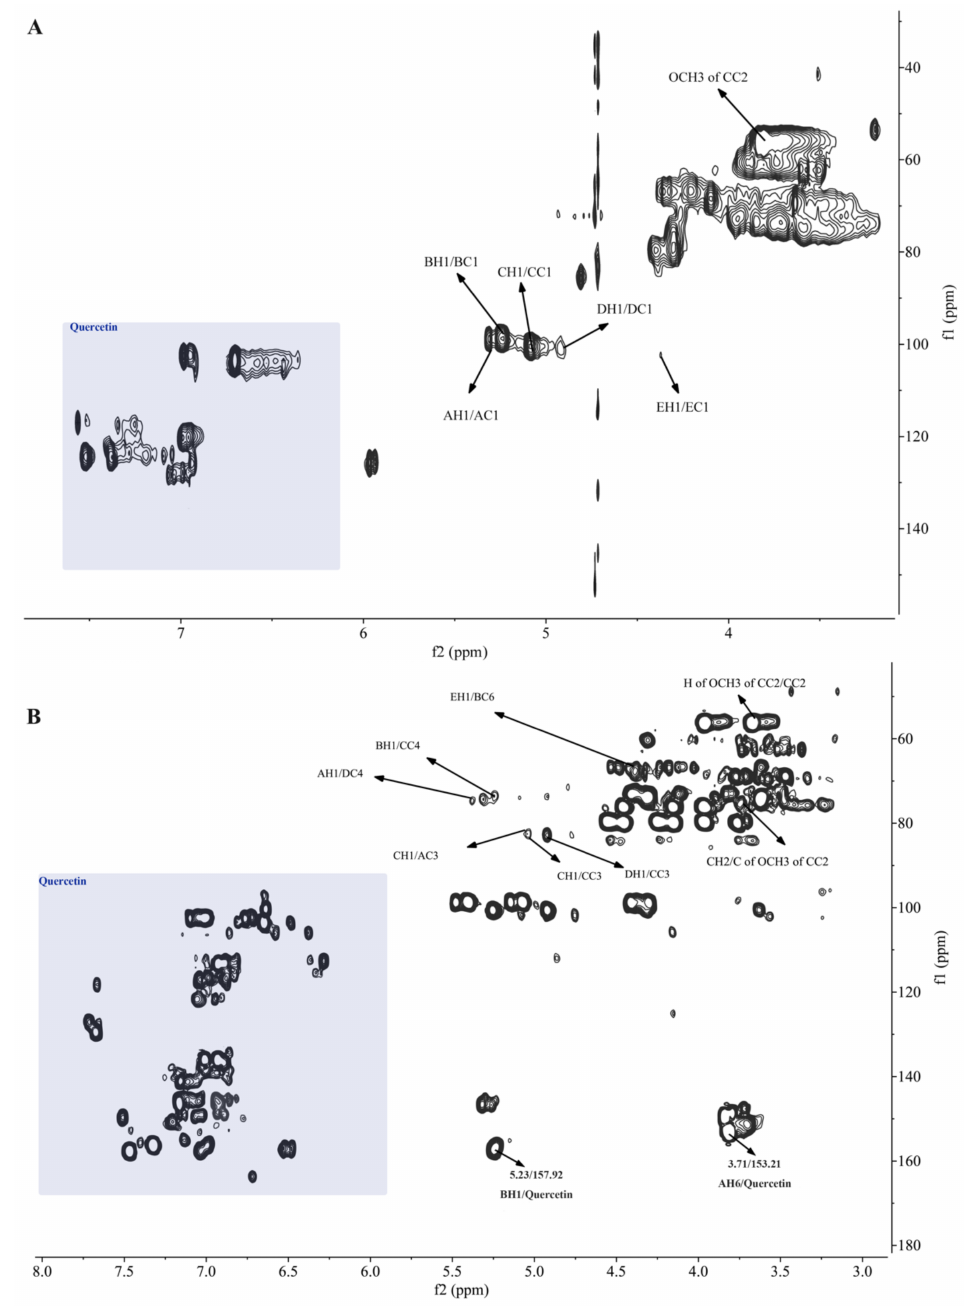
Figure 4. HSQC ( A ) spectrum and HMBC ( B ) spectrum of